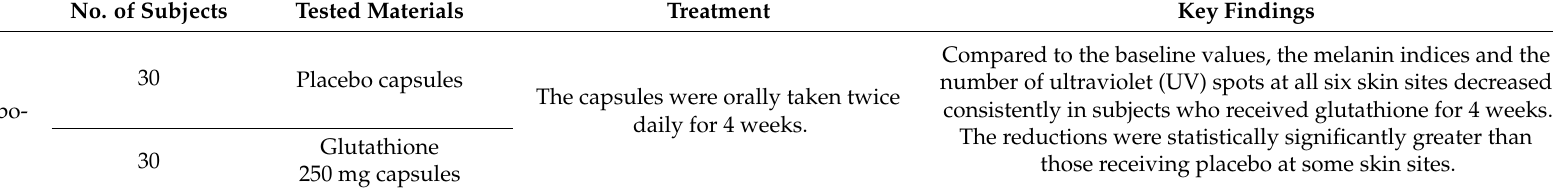
Table 1. Clinical trials on the skin lightening efficacy of glutathione and glutathione